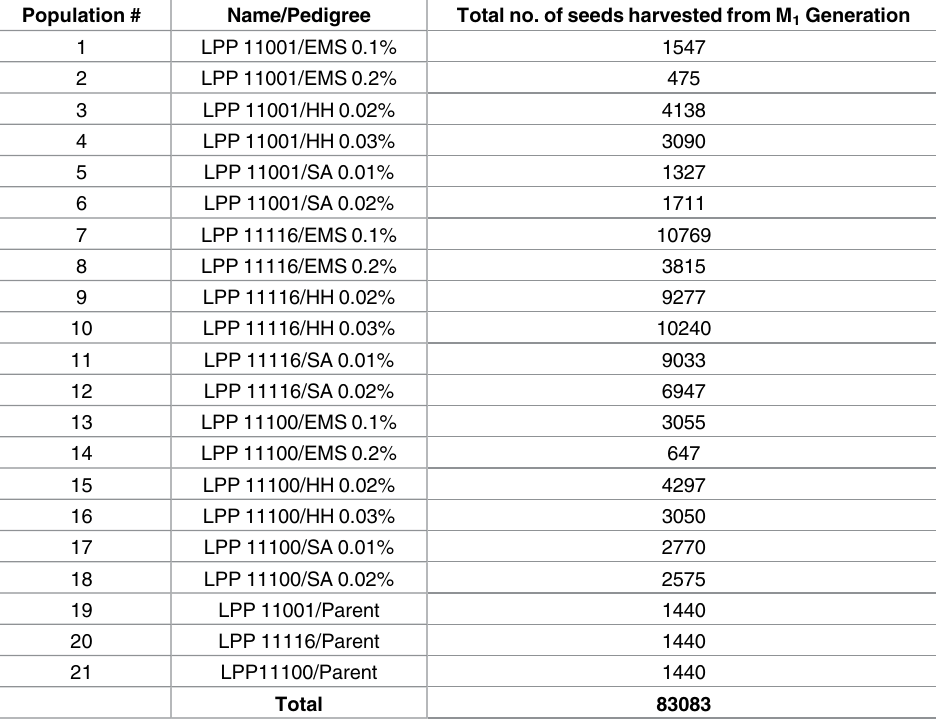
Table 3. Description of M 2 populations of lentil derived through chemical